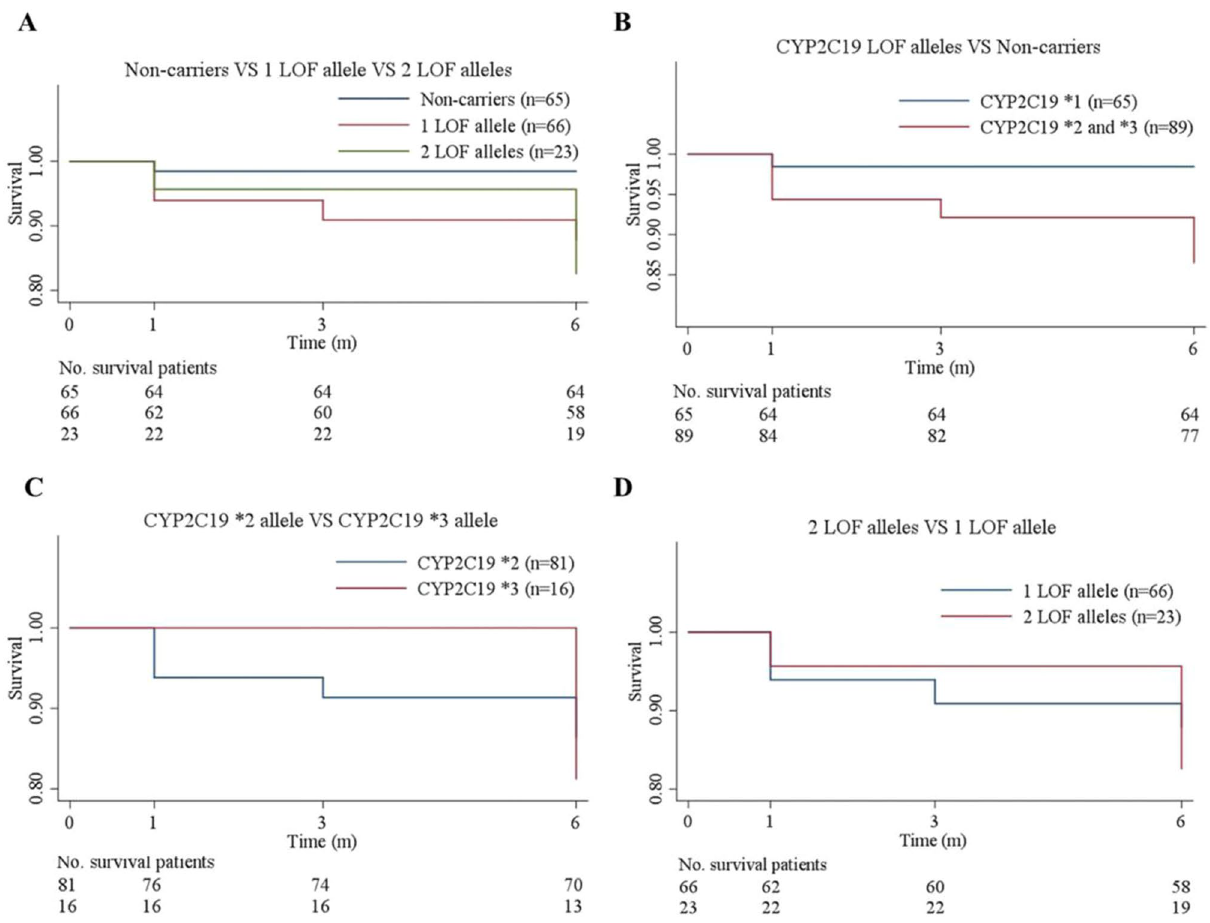
Figure 1. Rates of recurrence of ischemic event-free survival over 6 months of follow-up. ( A ) Patients with 1 LOF allele, including the genotypes *1 / *2 , and *1 / *3 . Patients with 2 LOF alleles, including the genotypes *2 / *2 and *2 / *3 . The genotype of patients with non-carriers is CYP2C19 *1 / *1 . These curves represent the percentage of patients who survived at the primary endpoints. The figures below the curves are the numbers of patients in different groups who survived at the endpoints and remained at risk during follow-up. ( B ) Patients with CYP2C19 LOF alleles, containing the following genotypes *1 / *2 , *1 / *3 , *2 / *2 , and *2 / *3 . ( C ) There was no difference in the cumulative survival rates between the CYP2C19*2 and CYP2C19*3 alleles. Patients with genotype *2 / *3 were counted twice because *2 / *3 were both included in these alleles. ( D ) There was no difference in the rates of recurrence of ischemic event-free survival between the two groups. LOF, loss-of- function. Figures were drawn using STATA 12.0 (Stata Corporation, College Station, TX,